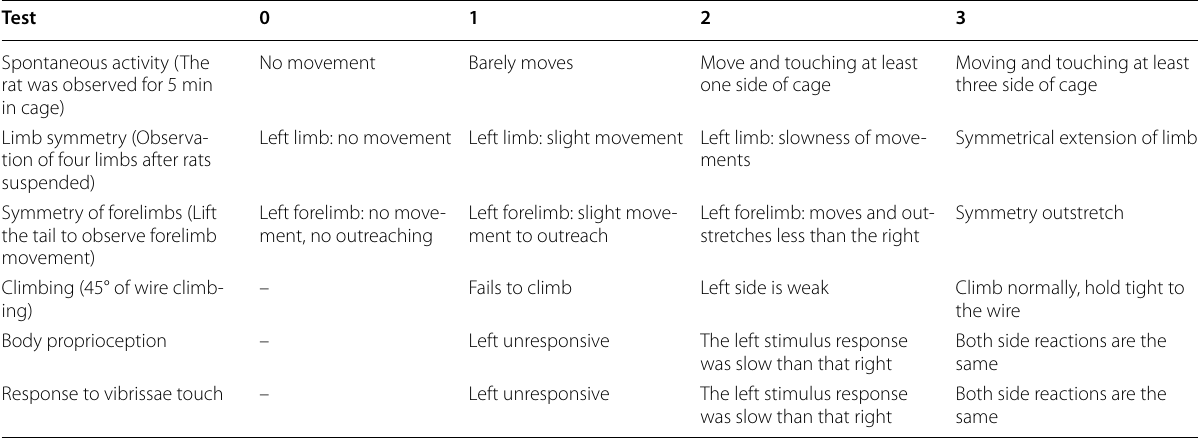
Table 1 Garcia JH Neurological Scoring Criteria for rats Test 0 Spontaneous activity (The rat was observed for 5 min Limb symmetry (Observa- tion of four limbs after